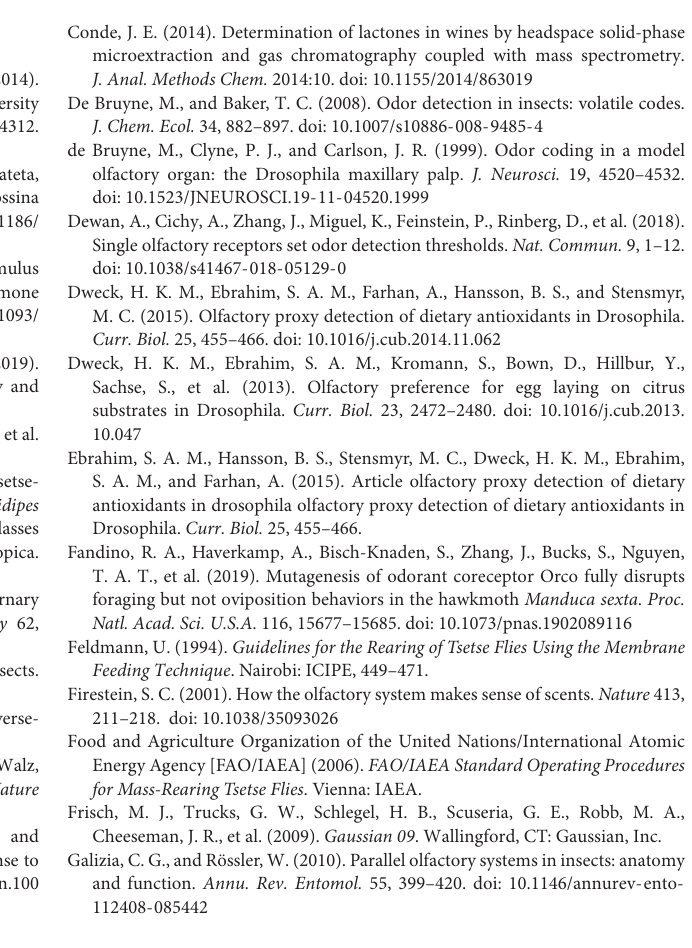
TABLE S3 | Alteration of G. f. fuscipes OR mRNA and D. melanogaster vs G. f. fuscipes orthologs genes response